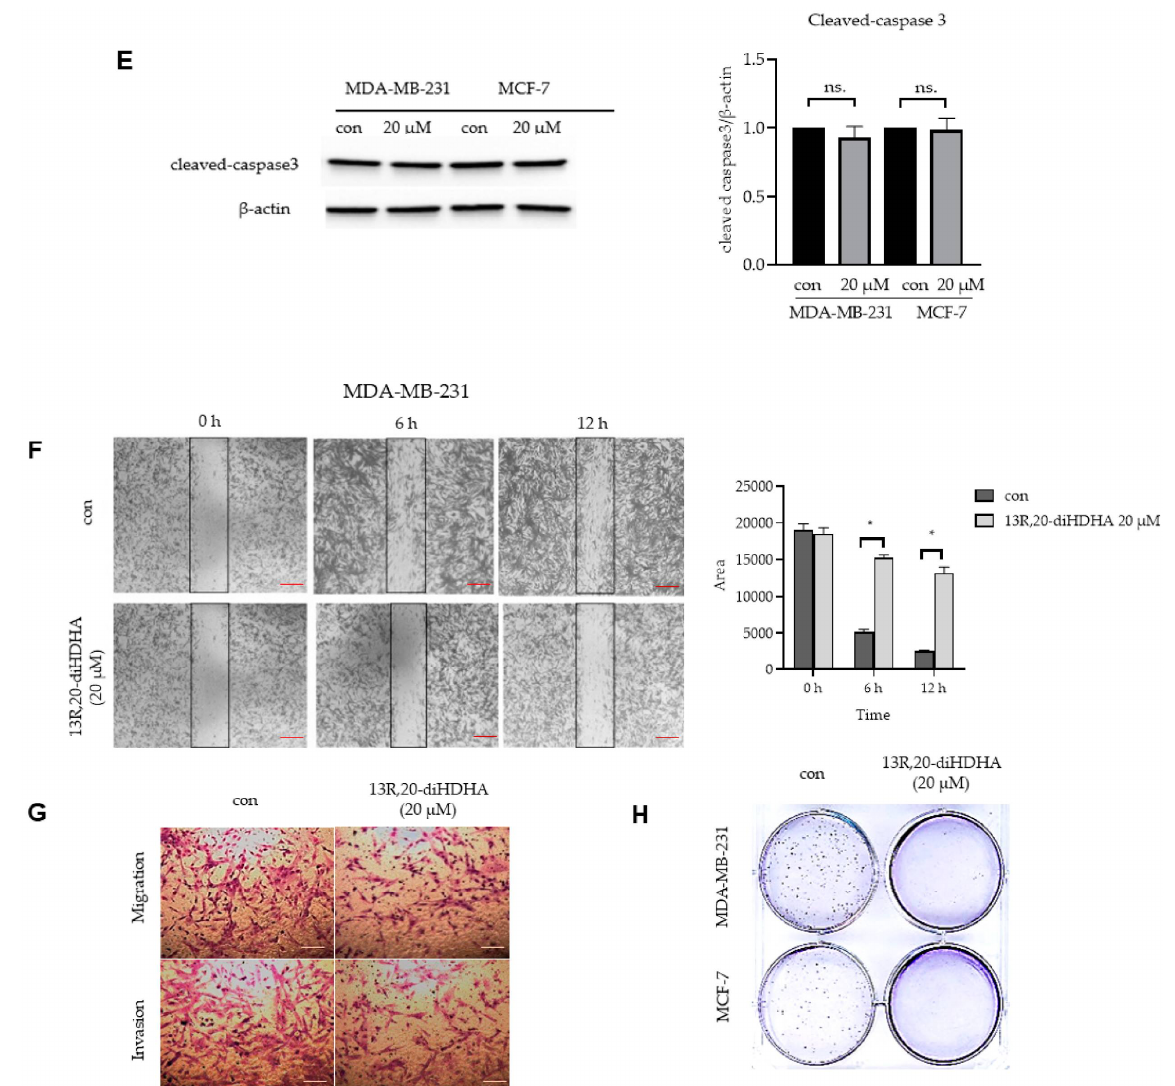
Figure 2. The effect of 13 R ,20-diHDHA on mammospheres formation and multiple cancer hallmarks in breast cancer cell lines. ( A ) MDA-MB-231 and MCF-7 cells were cultured in a 96-well plate with various concentrations of 13 R ,20-diHDHA for 24 h and cancer cell proliferation was assayed with a CellTiter 96 ® AQueous One Solution kit. ( B ) The mammospheres formation efficiency (MFE) was decreased by 13 R ,20-diHDHA treatment. Mammospheres derived from MDA-MB-231 cells were cultured for 7 days in the presence of 13 R ,20-diHDHA or DMSO. Image shows the sizes of representative mammospheres, as obtained by microscopy (scale bar: 100 µ m). * p < 0.05 versus the DMSO-treated control group. ( C ) 13 R ,20-diHDHA prevents mammospheres growth. Mammospheres were treated with 13 R ,20-diHDHA for 2